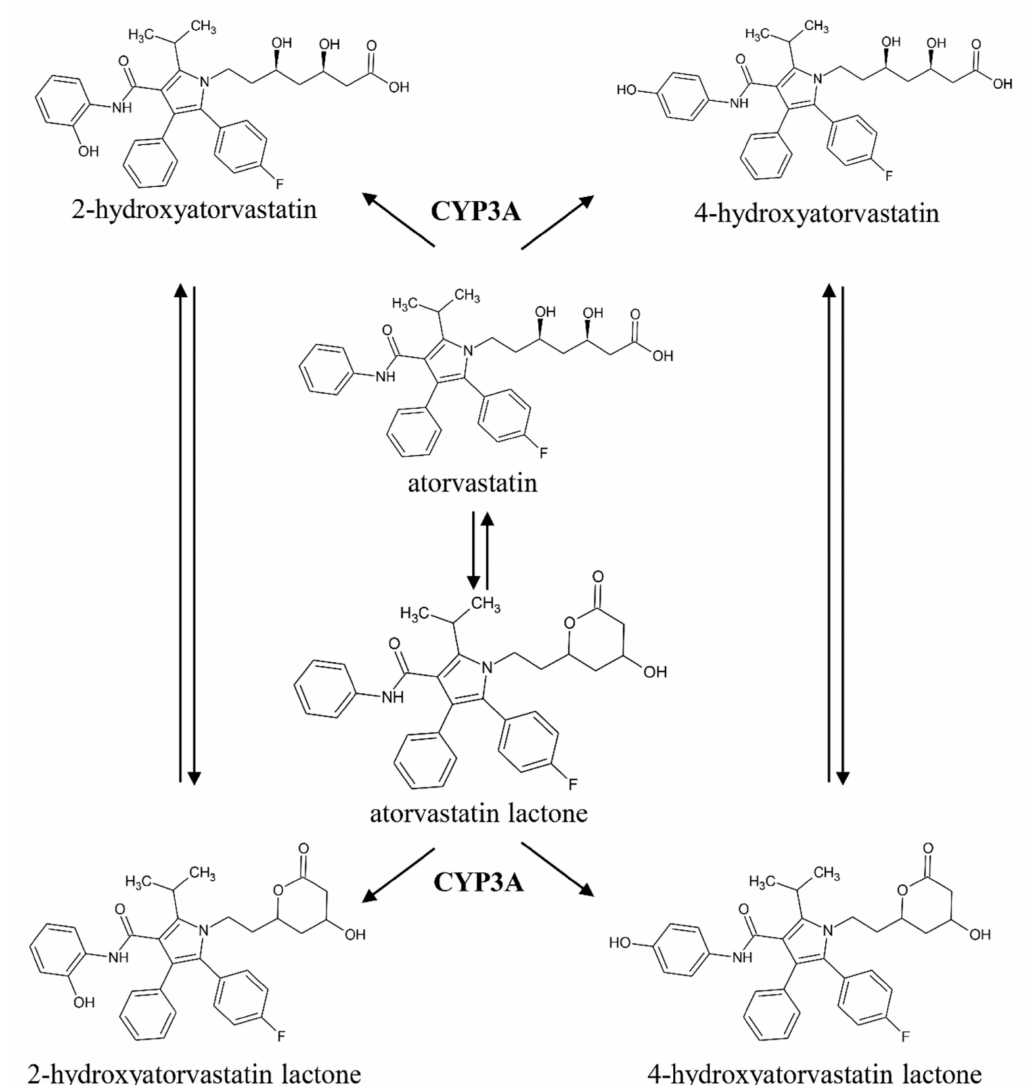
Figure 1. Overview of atorvastatin metabolism. The production of hydroxylated metabolites is catalyzed by cytochrome P450 3A isoenzymes. (CYP3A). The acid and the lactone forms of the parent drug and the metabolites are in equilibrium in